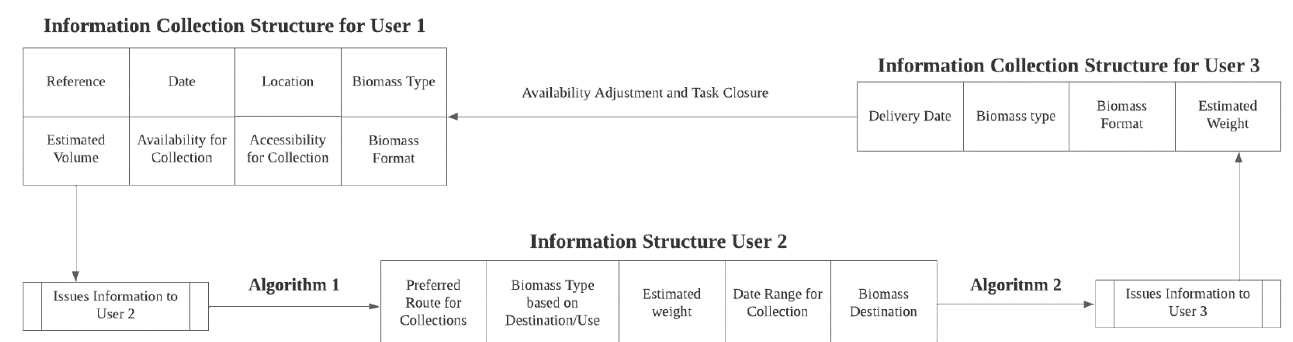
Figure 7. Information flow and information collection tables in the user-friendly interface.